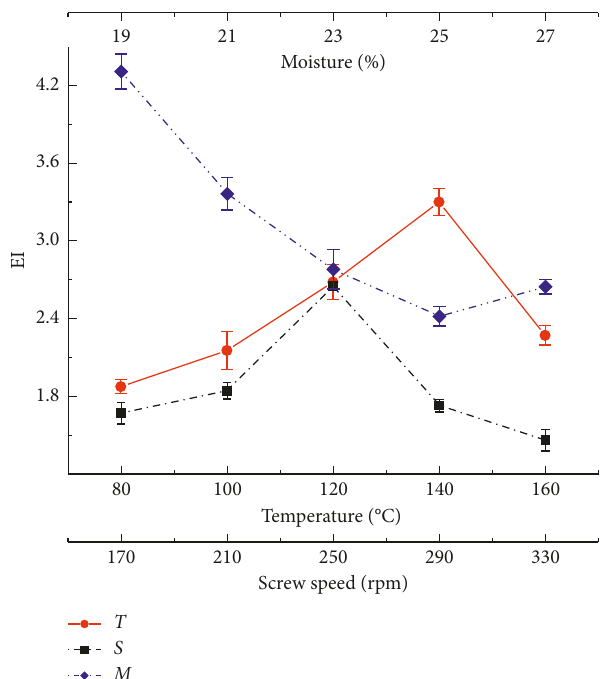
Figure 1: Expansion index of adlay flour treated by different extrusion conditions T (barrel temperature), S (screw speed), and M (moisture